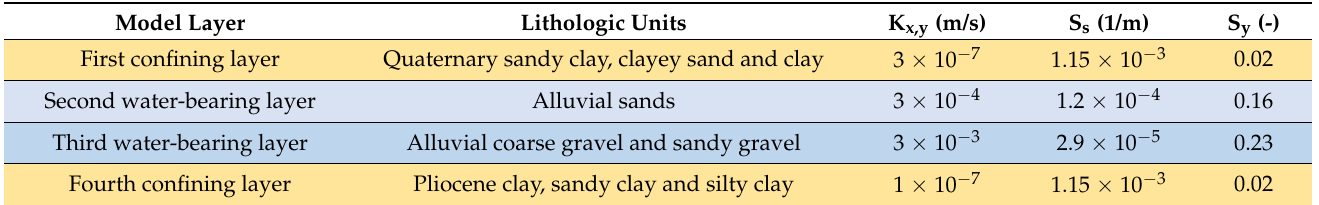
Table 1. Representation of the flow field-lithologic units in the model layers with initial values of hydraulic conductivity (K), specific storage (S s ) and specific yield (S y ).